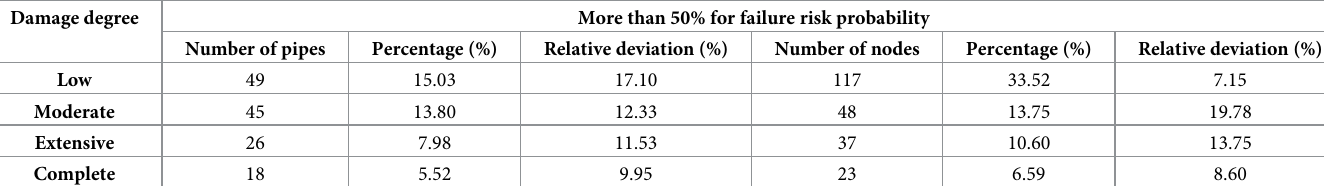
Table 6. Risk degree analysis of water supply network in Shengpu subregion based on ANP